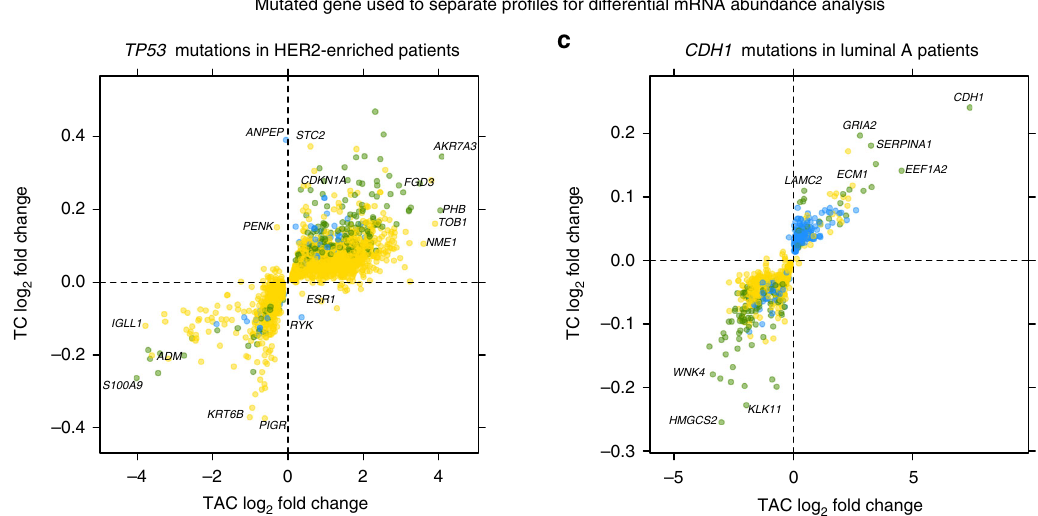
Fig. 6 Differential mRNA abundance associated with mutated genes. Counts of genes with differential mRNA abundance associated with mutated genes in each subtype for TAC and TC mRNA abundance ( a , bottom three panels). The x axis are the mutated genes used in the analysis ordered by the frequency that the gene was mutated in each subtype ( a , top panel). *HER2 = HER2-enriched. Speci fi c genes are elaborated on showing the differences between TC and TAC mRNA abundance fold changes associated with TP53 mutations in HER2-enriched patients ( b ) and CDH1 mutations in patients with luminal A breast cancers ( c